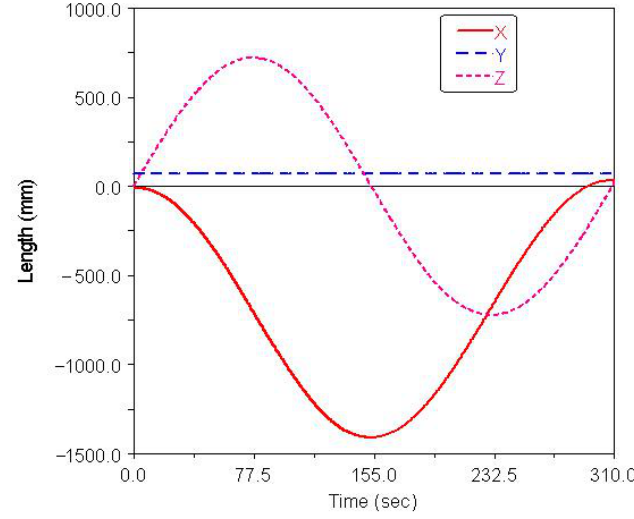
Figure 8. Centroid displacement curve of turning gait.